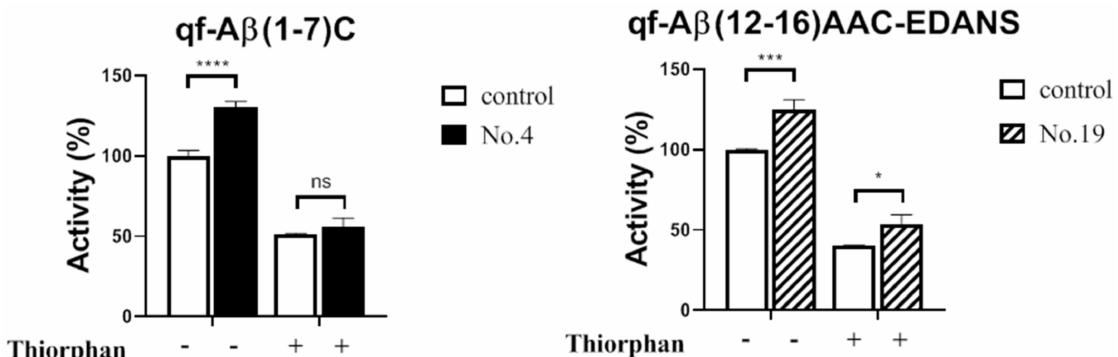
Figure 5. Thiorphan inhibition assay. SH-SY5Y cells were incubated for 12 h in the presence or not of compound 4 or 19 (5 µ M), followed by thiorphan (50 µ M) for 30 min before A β -degrading activity was measured using the appropriate substrate. The data are the mean ± SD for three independent samples. * p < 0.05; *** p < 0.001; ****, p < 0.0001 compared to the control by one-way